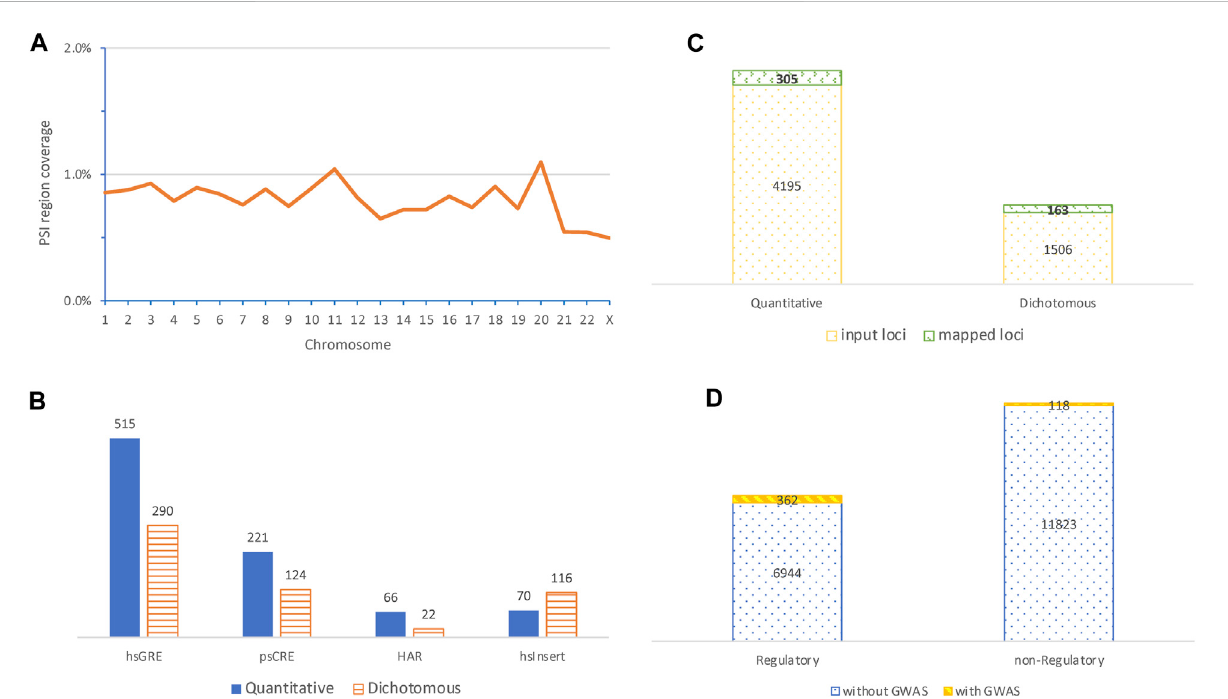
FIGURE 1 Characteristics of PSI regions and their colocalization with variants identi fi ed in genome-wide association studies. (A) Distribution of chromosomal coverage of PSI regions (top left); (B) contrast of the number of mapped GWAS variants identi fi ed in quantitative traits with that from dichotomous diseases by four mostly mapped PSI types (bottom left); (C) contrast of the number of input GWAS loci with the number of loci mapped to PSI regions by categories of quantitative or dichotomous phenotypes (top right); (D) comparison of the number of PSI regions with no GWAS loci mapped to against that with mapped GWAS loci by categories of PSI regions with or without obvious regulatory roles (bottom right, PSI regions with multiple PSI types were excluded for